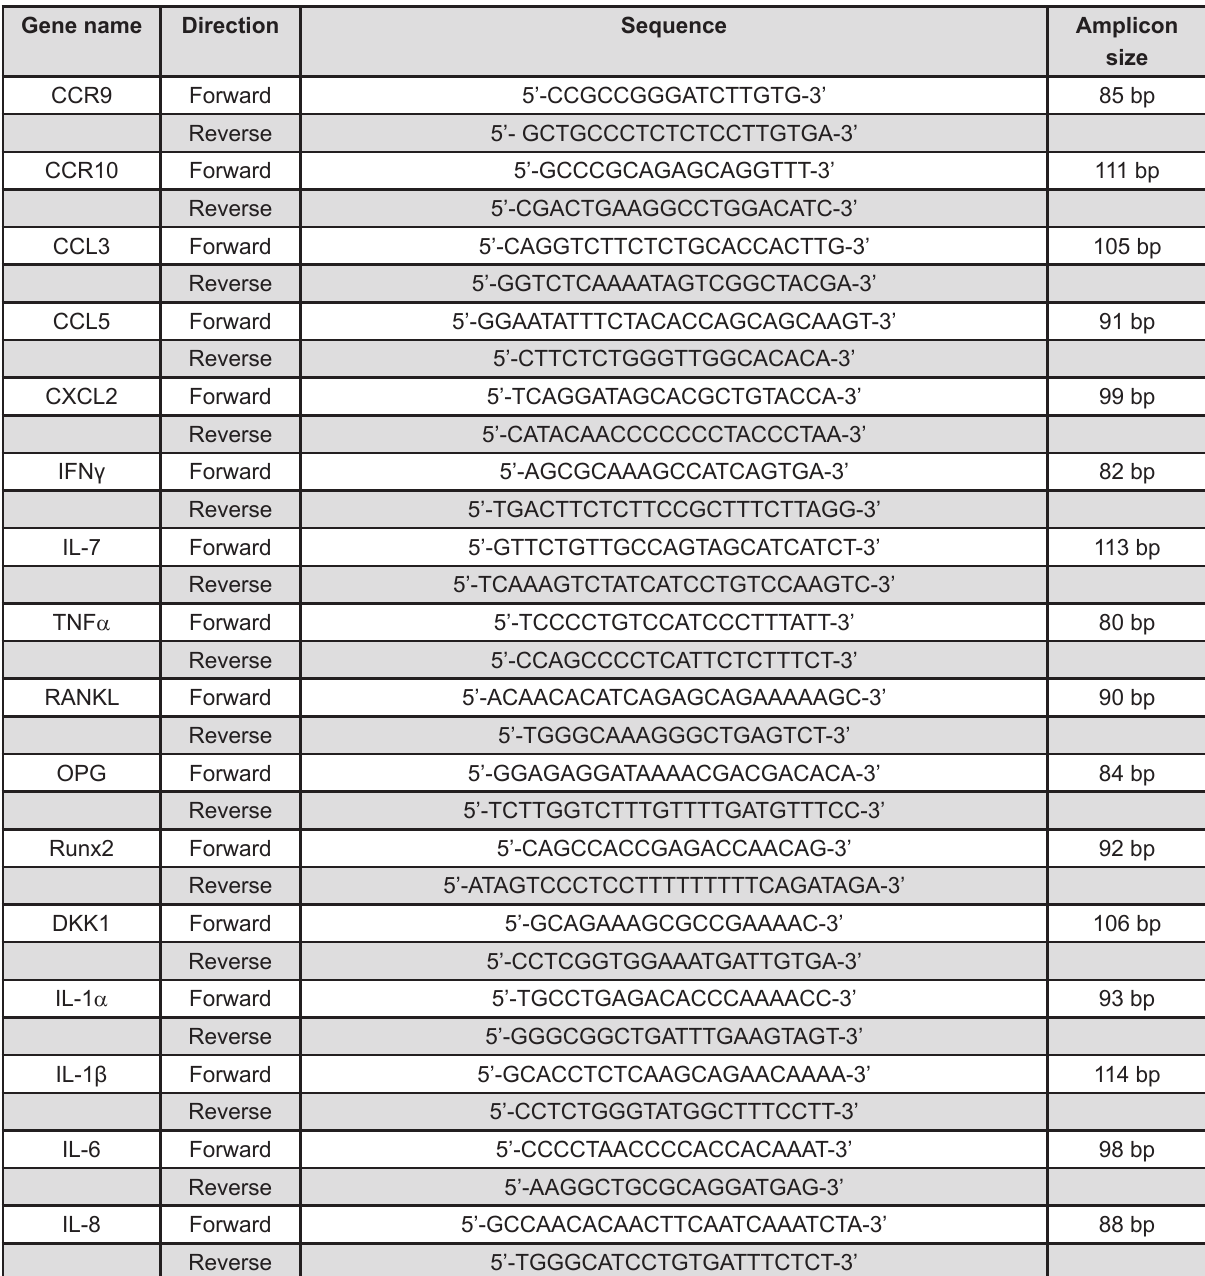
Figure 2- Primers used for the quantitative real-time